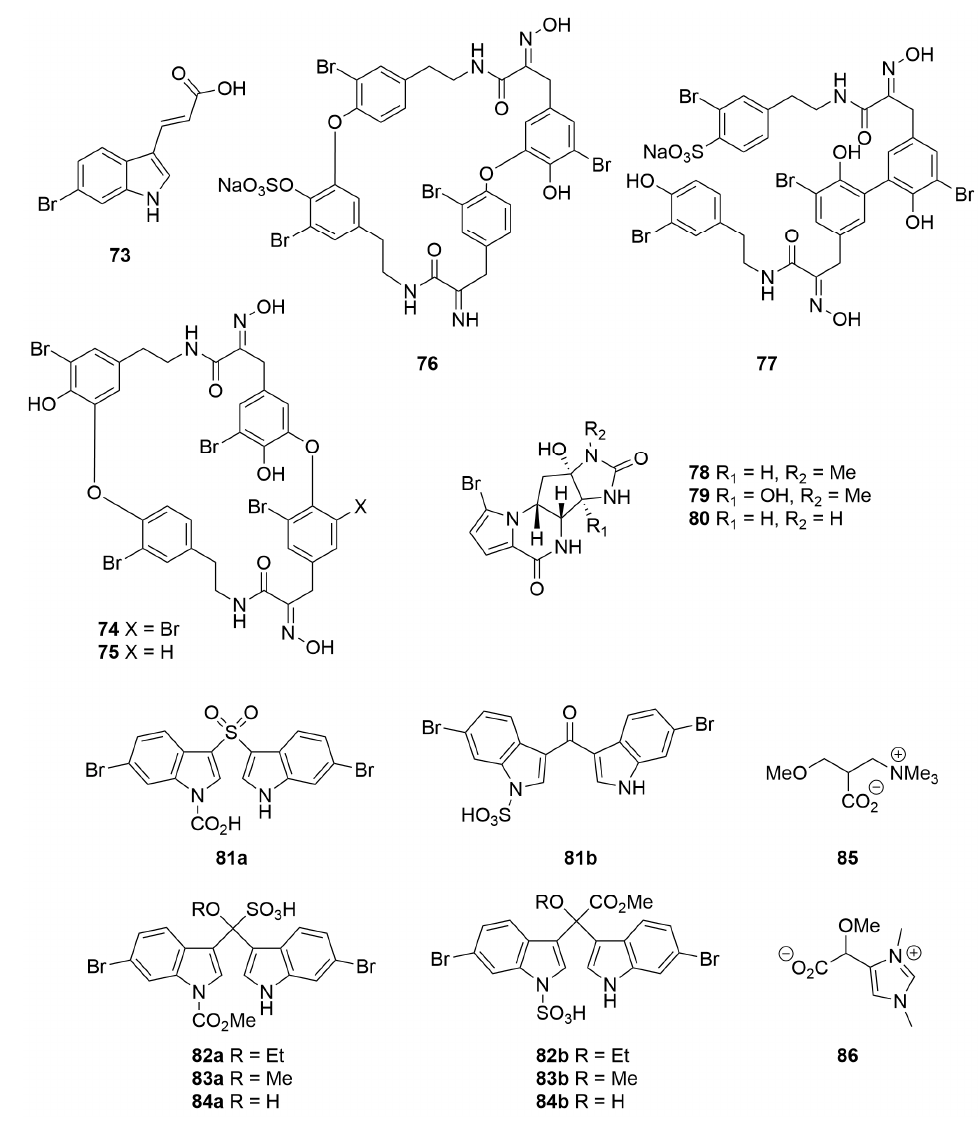
Figure 5. Compounds 73 to 86 .